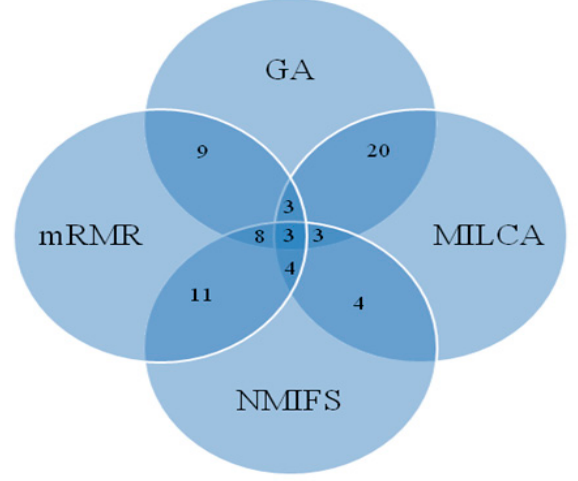
Figure 3. Behavior of the different algorithms for the selection of characteristics and common characteristics that are selected by more than one